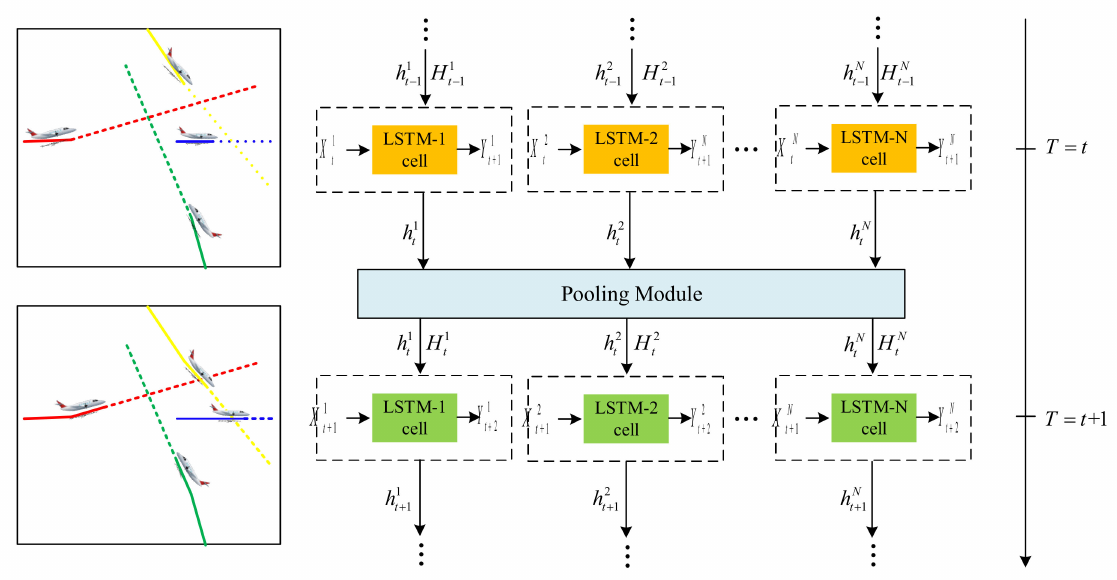
Figure 3. Social Long Short-Term Memory (S-LSTM) model structure.